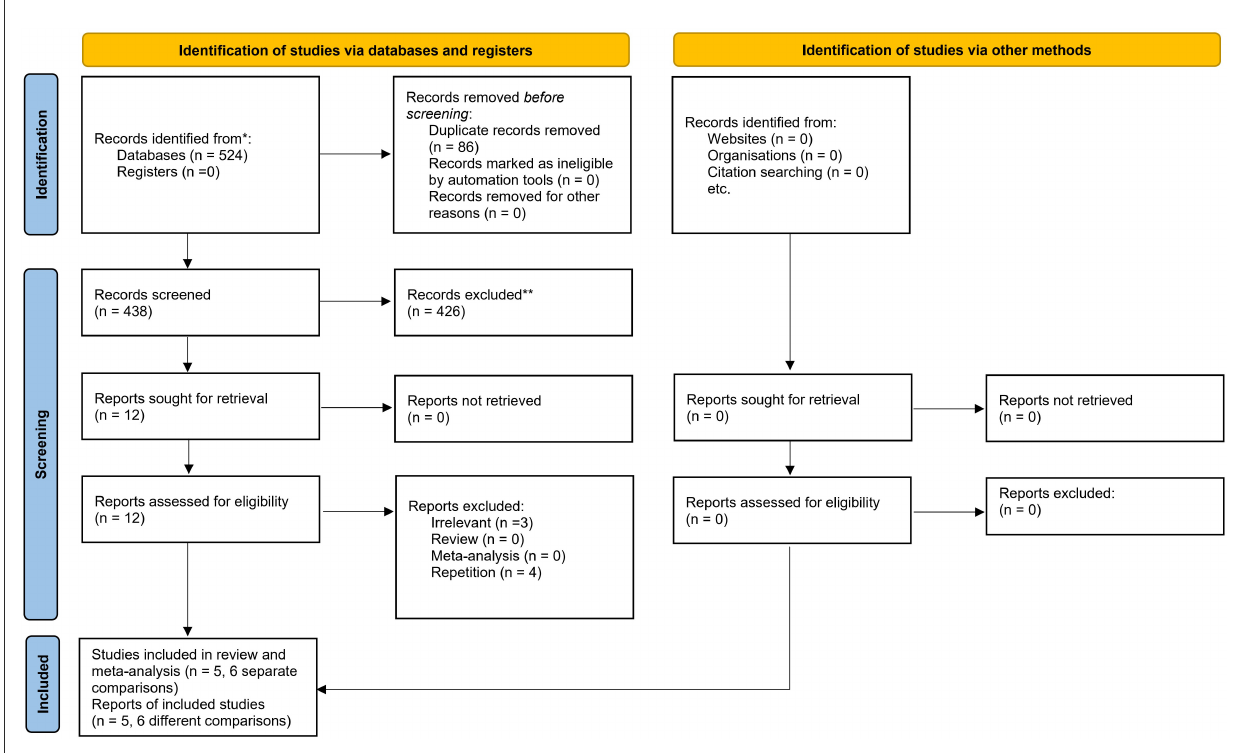
FIGURE1 PRISMA flow diagram of the study. From: Page MJ, McKenzie JE, Bossuyt PM, Boutron I, Hoffmann TC, Mulrow CD, et al. The PRISMA 2020 statement: an updated guideline for reporting systematic reviews. BMJ 2021;372:n71. doi: 10.3389/10.1136/bmj.n71. For more information, visit: